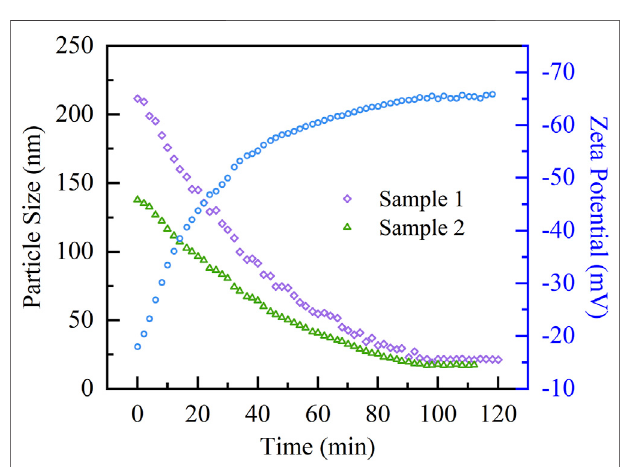
Frontiers in Materials |